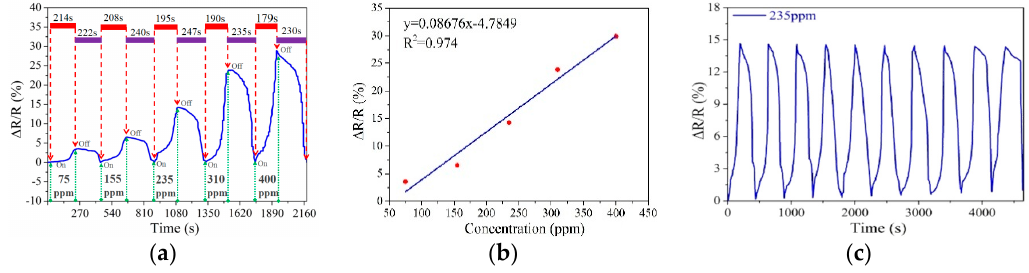
Figure 4. ( a ) The real-time response/recovery behavior of the sensor to various concentrations of ammonia gas from 75 to 400 ppm; ( b ) The normalized resistance changes of the sensor to various concentrations of ammonia gas from 75 to 400 ppm; ( c ) Real-time cycling response of the sensor with 120 μ m width to 235 ppm NH 3 gas.